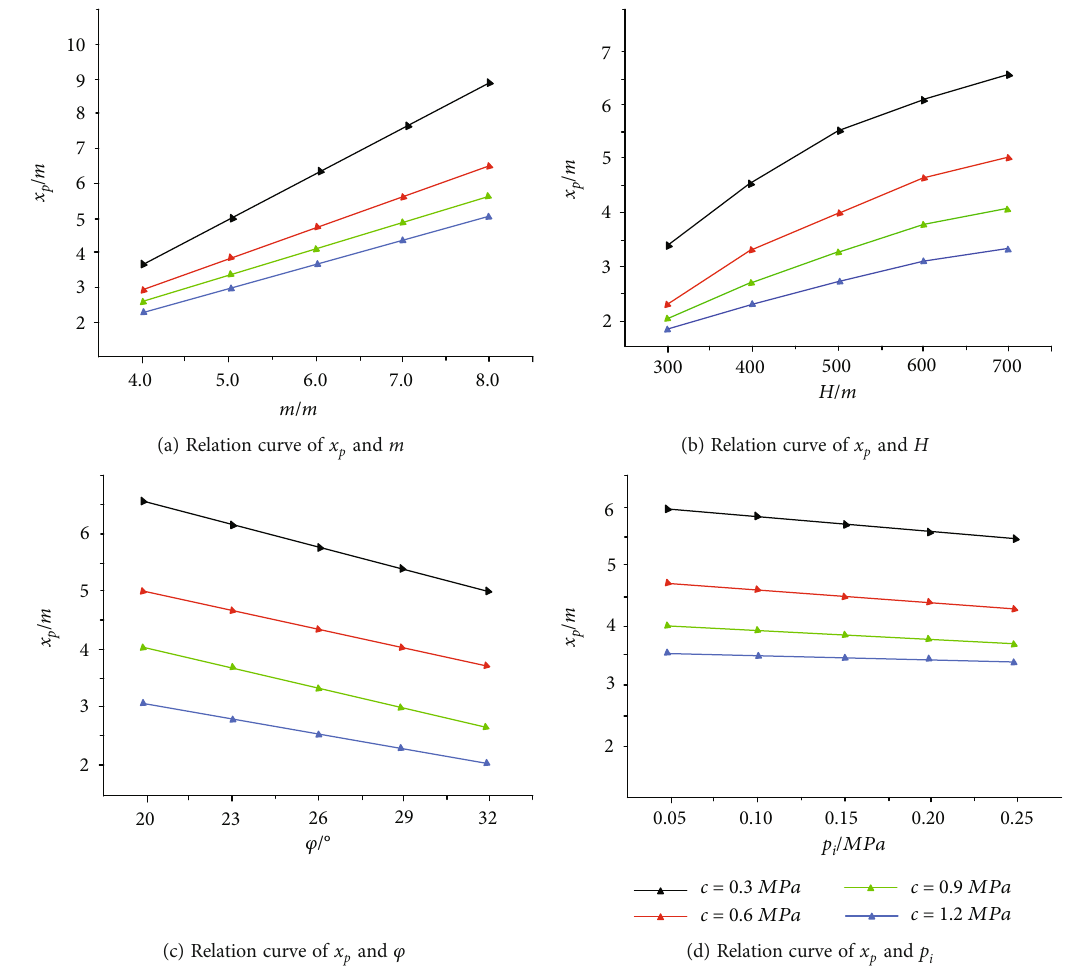
Figure 3: Analysis of in fl uencing factors of x